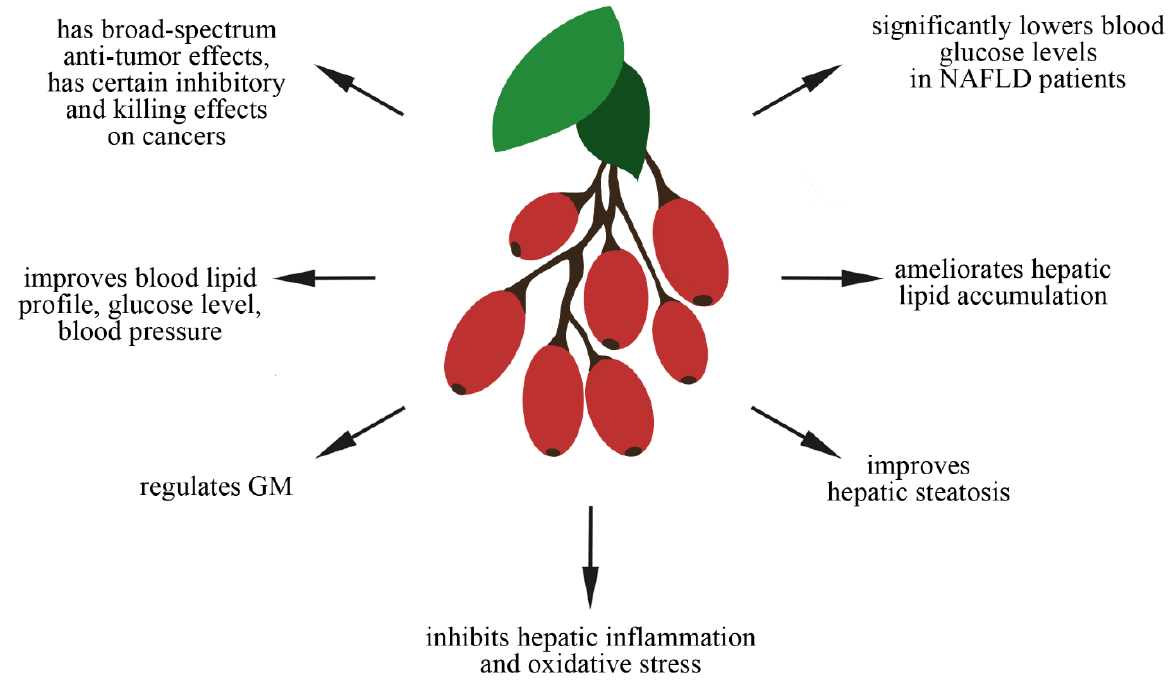
Figure 1. Actions of BBR.